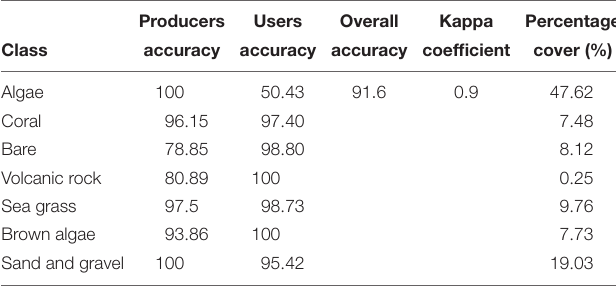
TABLE 2 | Local knowledge information through community participatory approach on fisheries resources, socioeconomic livelihood, climate change perception, tourism and benthic cover change for Komave